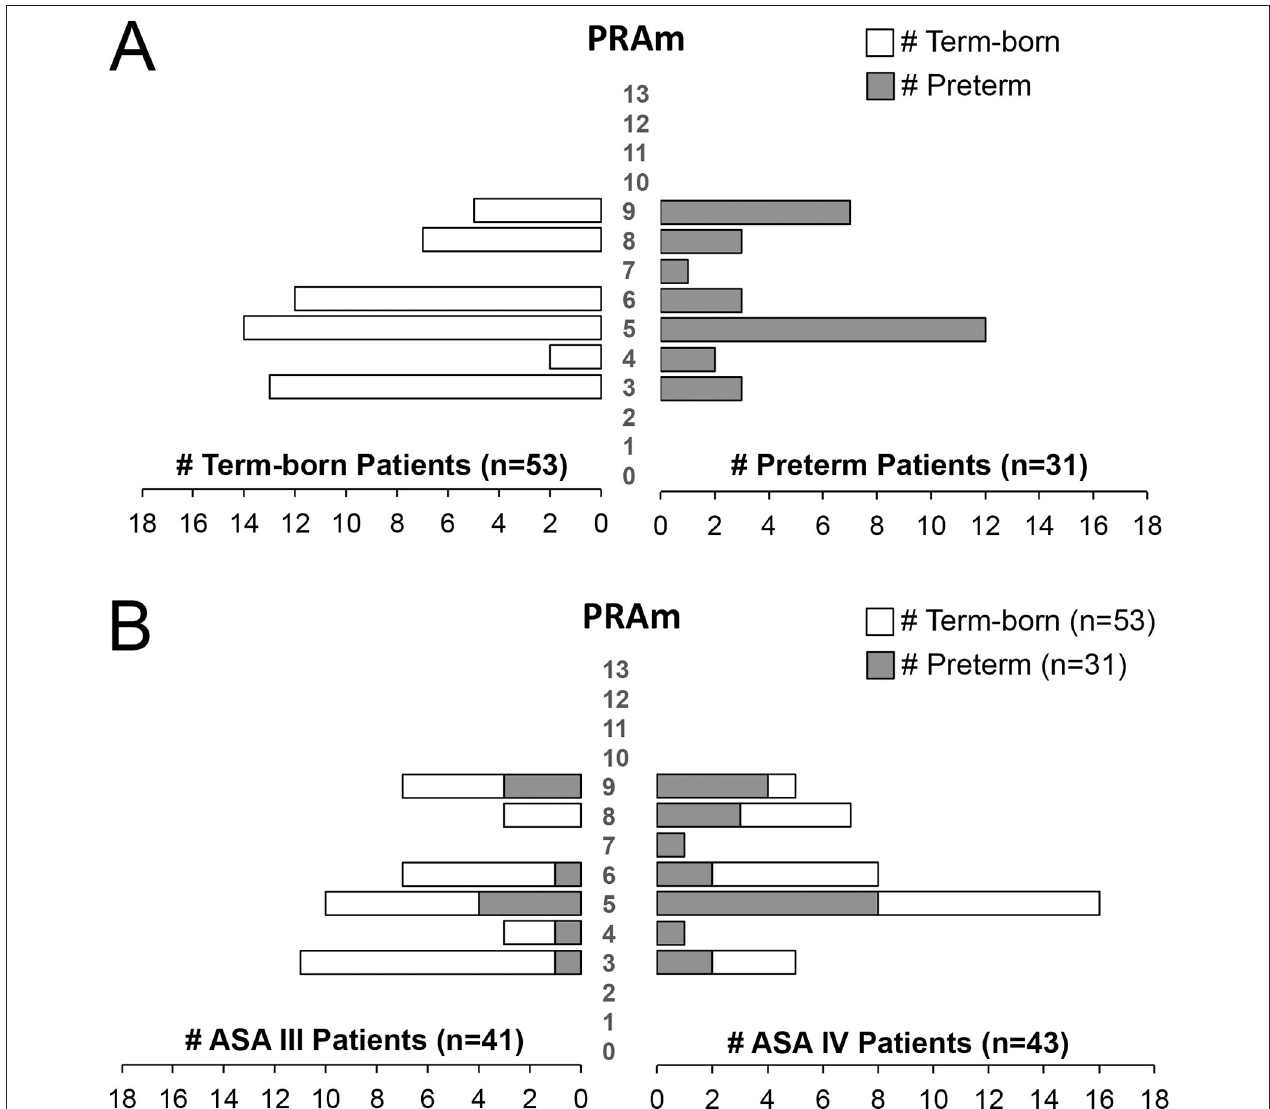
FIGURE 4 | Pediatric Risk Assessment (PRAm) Scores in a Retrospective Cohort of Infants Born with Esophageal Atresia. (A) Shows PRAm scores of term-born (left) and preterm patients (right) illustrating a wide range of PRAm score across gestational age of infants born with esophageal atresia (EA; n = 84). Note a subtle tendency of term-born patients for lower, and premature patients for higher PRAm scores. (B) Plots PRAm scores in relation to American Society of Anesthesiologists (ASA) Physical Status Classification. Despite more premature infants having had higher ASA IV classification (21/31; 68%) in comparison to term-born (22/53; 41%; see also Figure 3A ), PRAm score shows wide distribution of scores between 3 and 9. Such outlining is in support of ASA and not PRAm scoring in assessing disease severity when gestational age is the primary